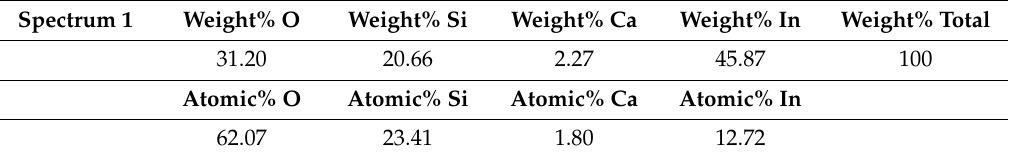
Figure 5. SEM micrography of a 230 nm thick film grown on glass. Table 1. Micronalysis data concerning the average value of the region enclosed by the red box area with a depth of approximately 1 µm (partly in glass)